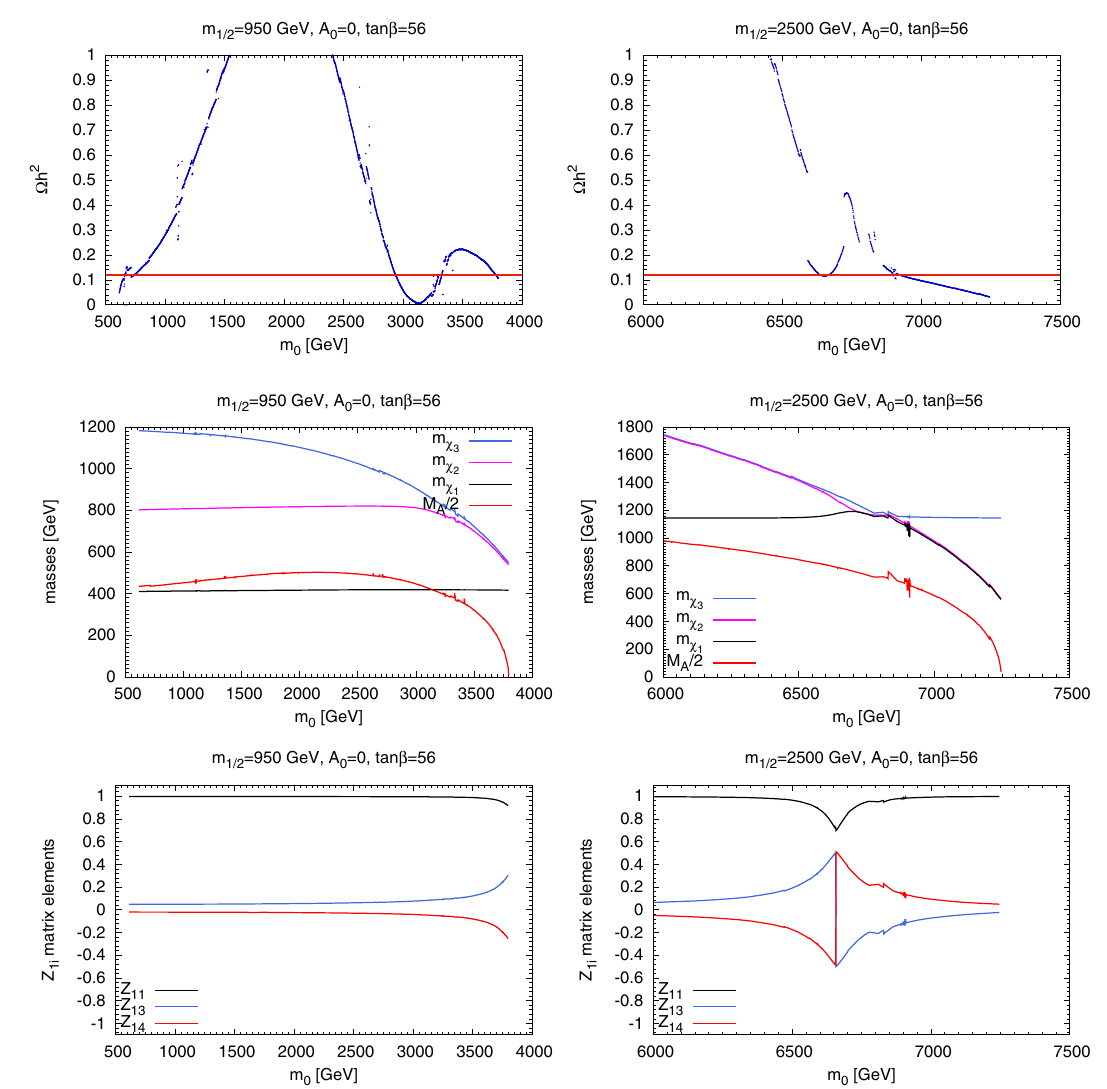
Fig. 5 Cuts across the ( m 1 / 2 , m 0 ) planes for tan β = 56, A 0 = 0 and μ > 0 for varying m 0 and fixed m 1 / 2 = 950 GeV (left panels) and 2 . 5 TeV (right panels), showing the dark matter density (top panels), particle masses (middle panels) and the composition of the LSP (bottom panels)